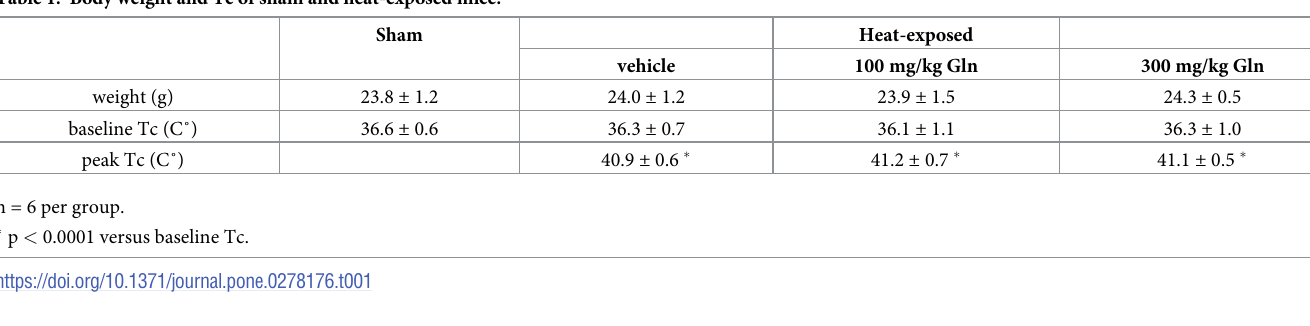
Table 1. Body weight and Tc of sham and heat-exposed mice.